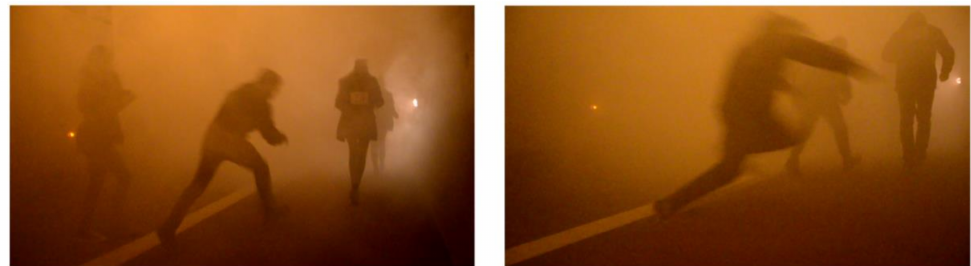
Figure 5. Two examples of participants tripping on the curb and falling during the road tunnel evacuation